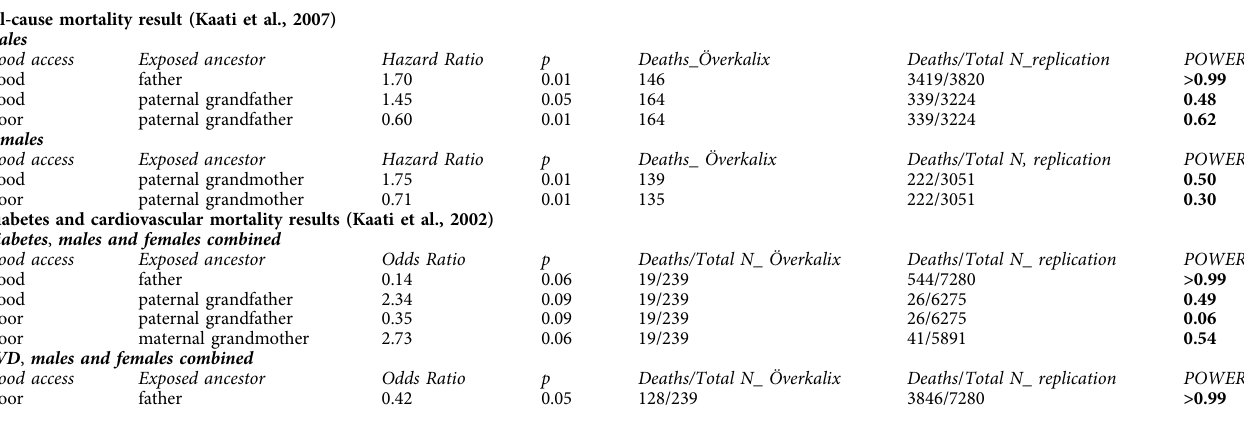
Supplementary Table 7: What is the power in our replication to detect the most important results in the Överkalix studies? All-cause mortality result (Kaati et al., 2007)